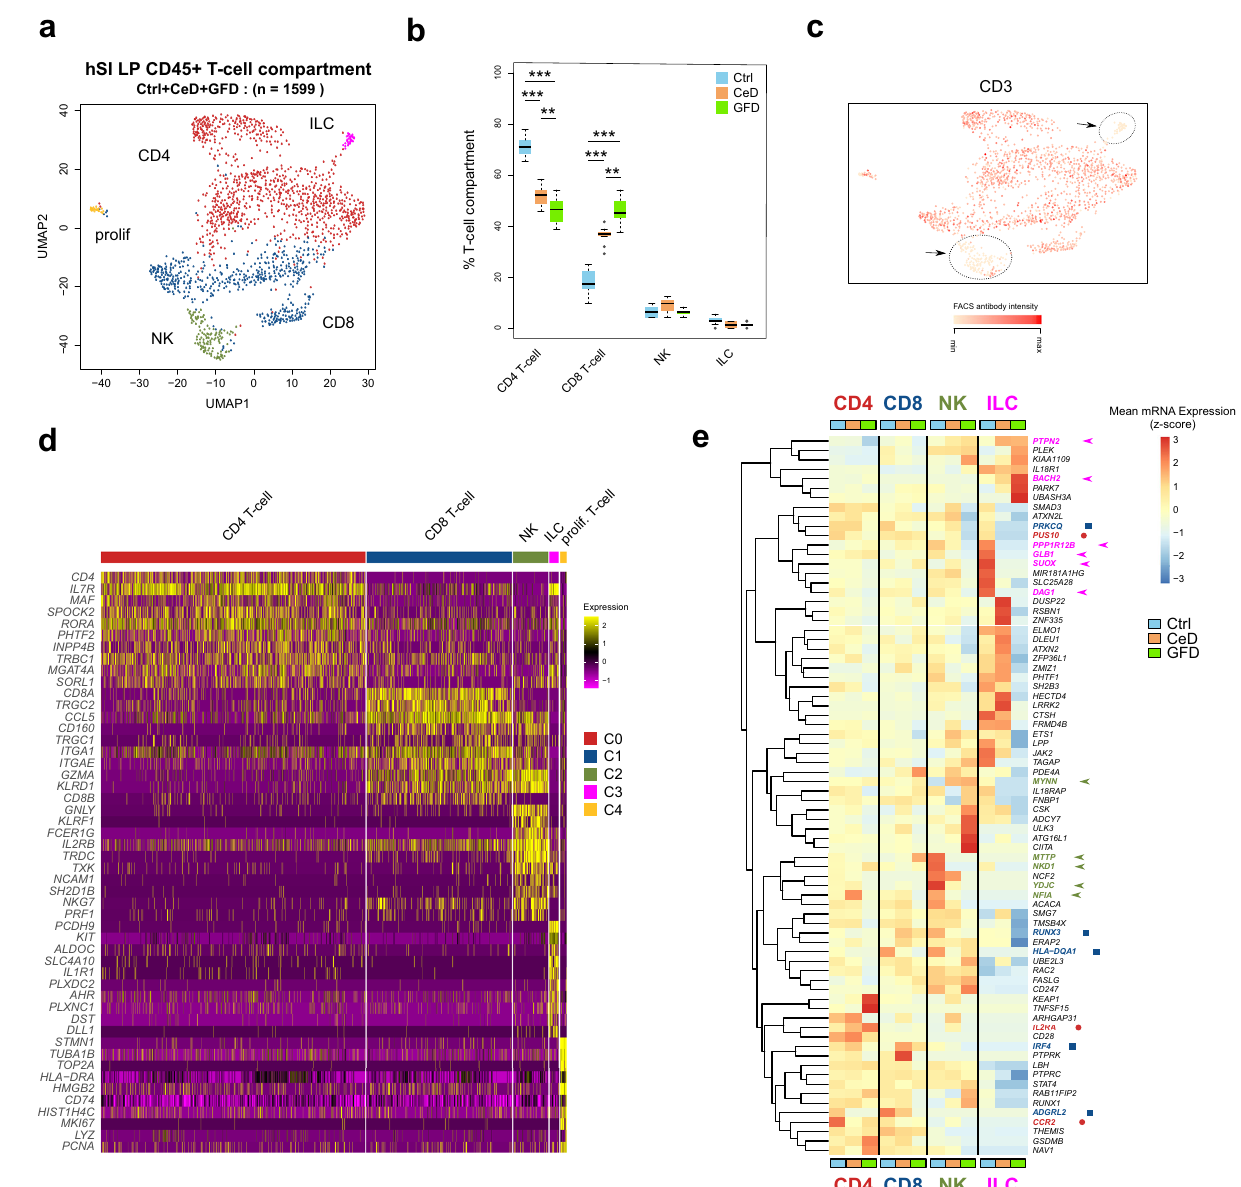
Fig. 3 | Single-cell landscape of T-cell compartment in human small intestine (LaminaPropria)inCtrl,CeDandGFDsamples.a UMAPclusteringplotofsingle- cell RNA-seq transcriptome pro fi les of cells in T-cell compartment (as in Fig. 1b) depictingCD4 + andCD8 + Tcells,Innatelymphoid cells(ILCs)and Naturalkillercell (NK)clusters(prolifproliferatingcells). b Boxplotsdepictingthepercentageofthe different cell types among the total number of the T-cell compartment across the UMAP clusters of Ctrl (control subjects), CeD (Celiac disease patients) and GFD